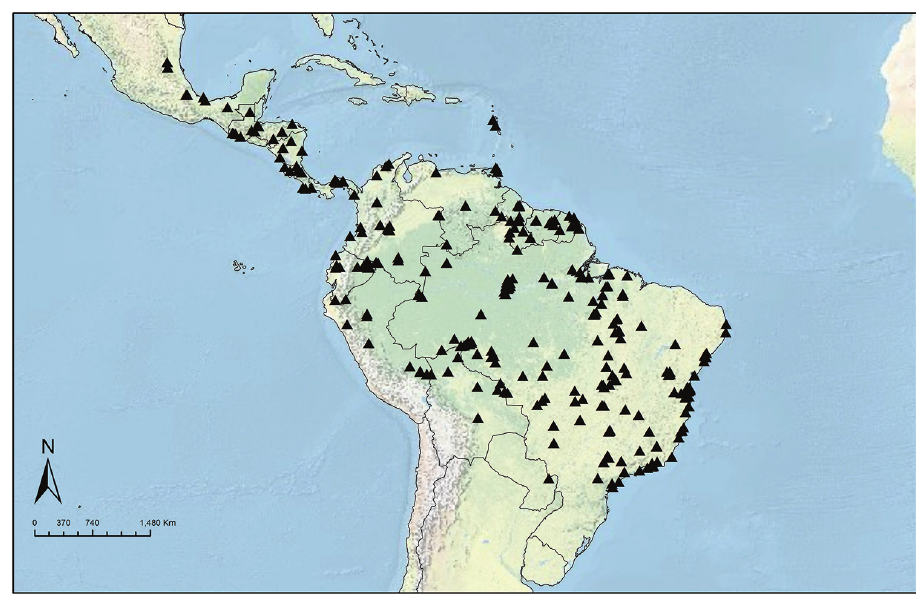
Figure 1. Distribution map of Sericomyrmex. Localities of specimens examined for this